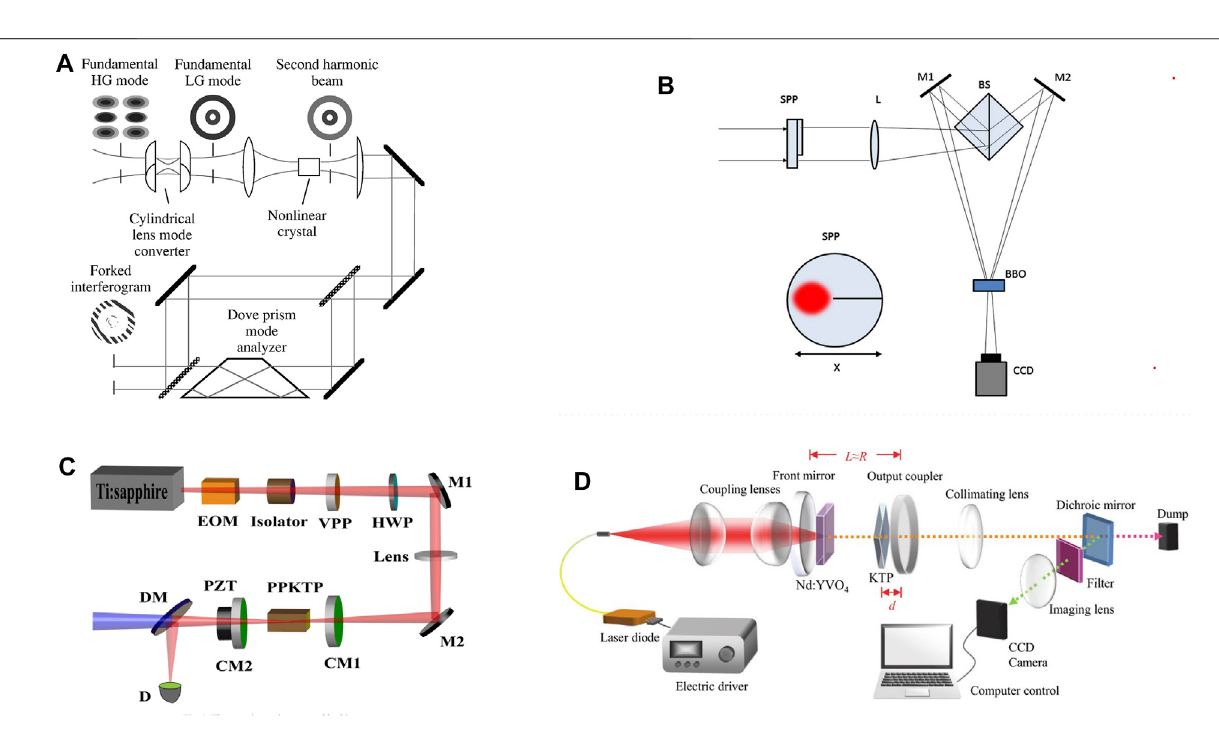
FIGURE3|(A) SHGoftheLGbeamconvertedfromaHGmodebyamodeconverter;[99] (B) Off-axisSHGwherethetopologicalchargewasintroducedbyahalf- integer spiral phase plate; [101] (C) quasi-phase-matched SHG of the vortex beam with a periodic-poled KTP [104]; (D) intra-cavity SHG of the bottle beam by an intra- cavity KTP